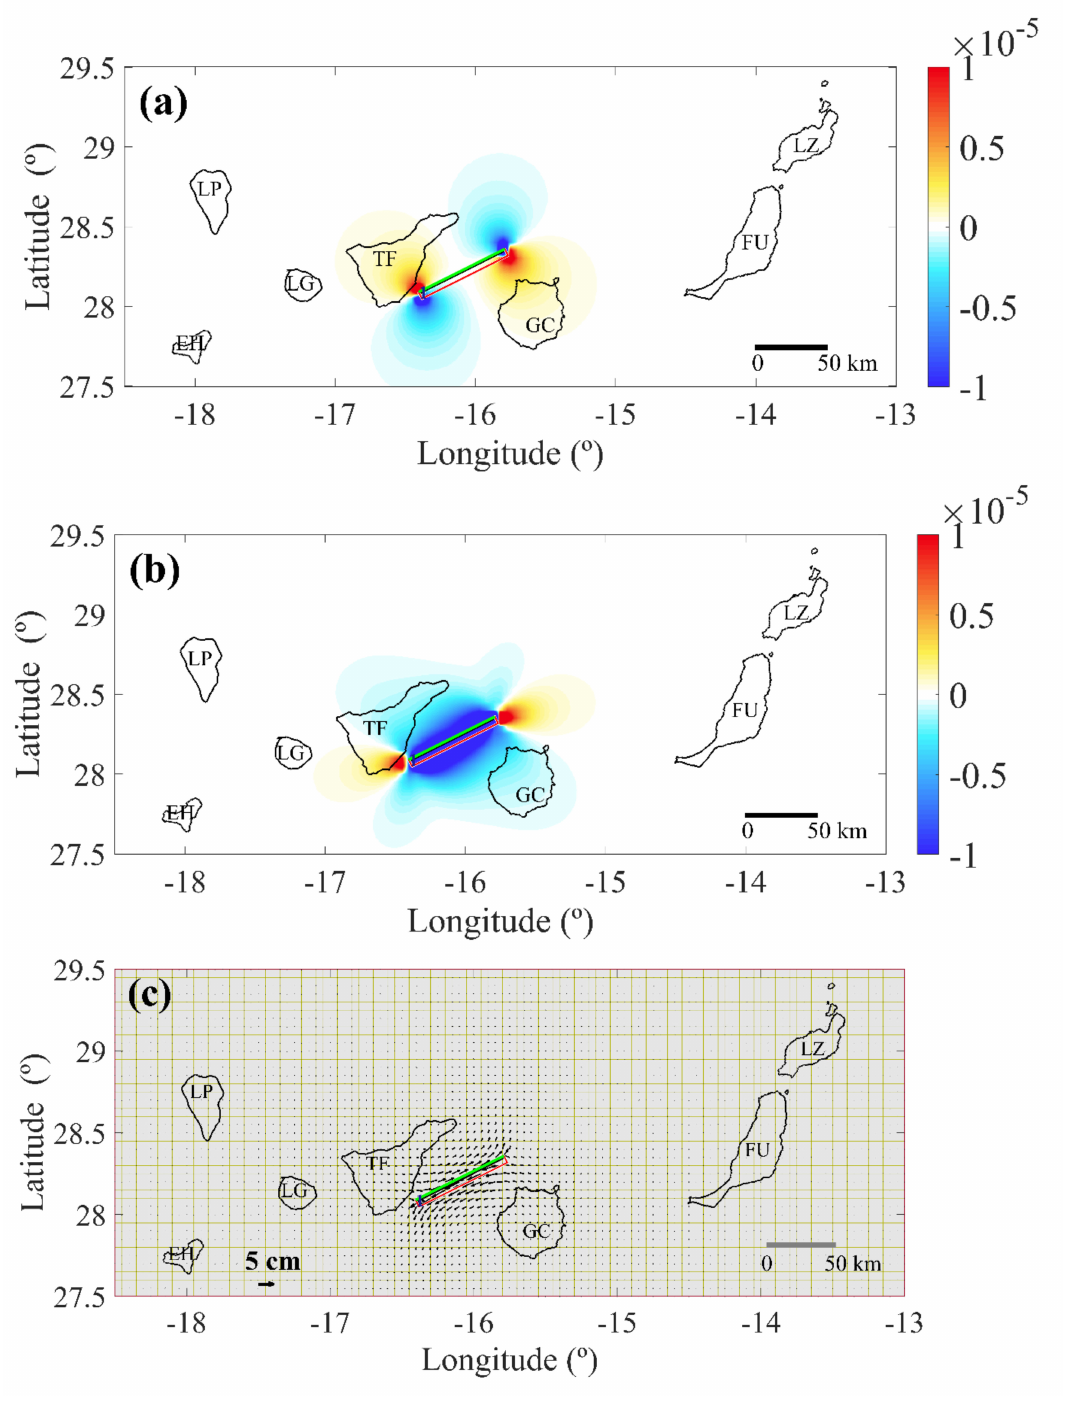
Figure 6. Dilatation ( a ), shear strain ( b ) and horizontal displacement ( c ) computed with Coulomb 3.4 software using the focal mechanisms of the 1989 earthquake (m bLg 5.2, depth 15 km, strike 33 ◦ , dip 71 ◦ , slip 166 ◦ ). The top and bottom depths of the active fault are set to 0 and 15 km, respectively, and the calculation depth is set to 4 km. The green line is the fault trace at the surface, while the red line is the projection to the surface of the fault frame; the black line is where the fault intersects the depth (the fault line at the target depth: 4 km). The blue digit refers to the number of dislocation sources used in the